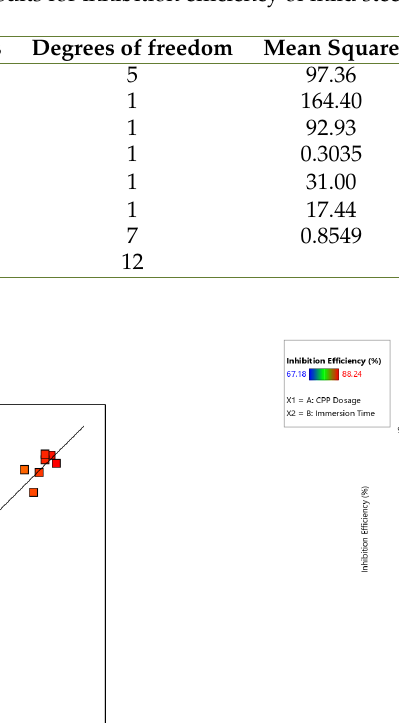
Table 2. ANOVA results for inhibition efficiency of mild steel in 1.0M HCl.